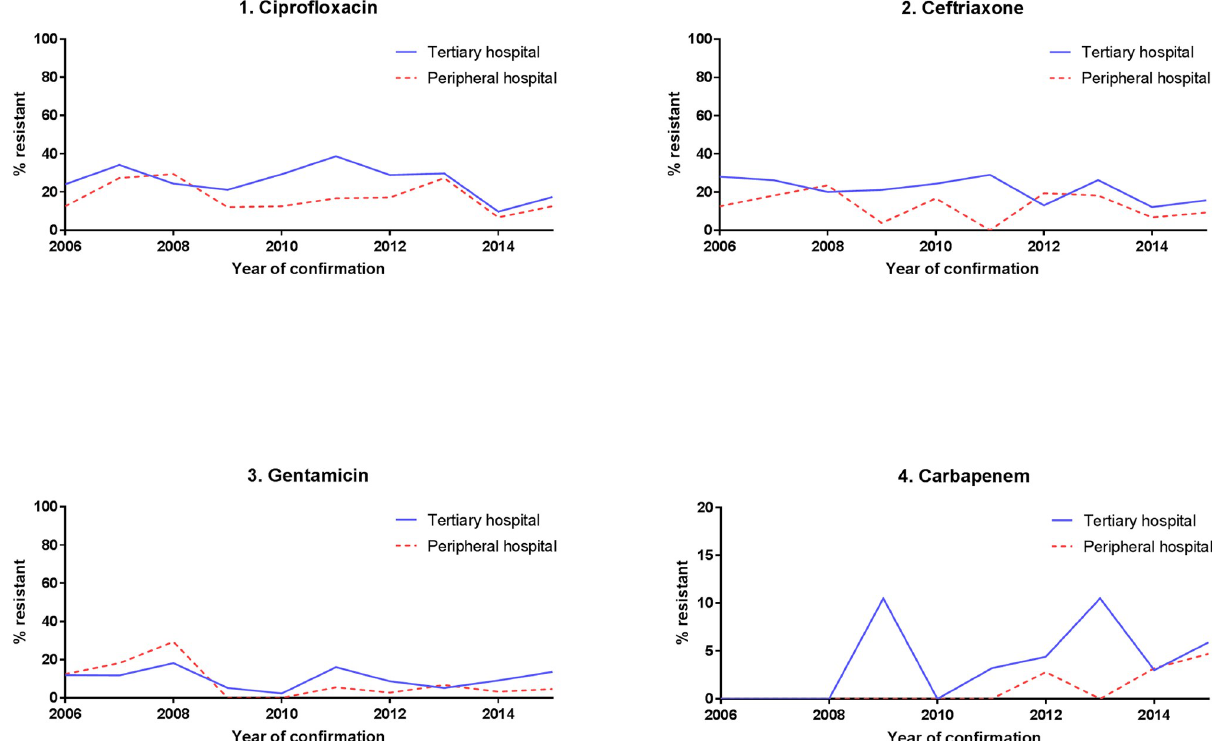
Fig 3. Proportion of antibiotic resistant Klebsiella sp . strains over time by hospital setting.